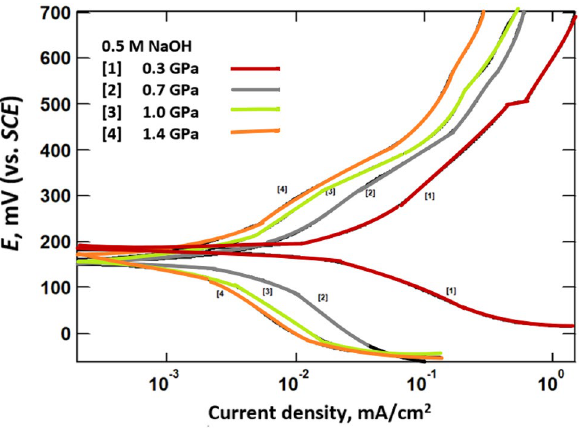
Figure 3. Potentiodynamic polarization curves of (Bi, Pb)-2223 superconductor electrodes compacted at different pressure in 0.5 M NaOH.